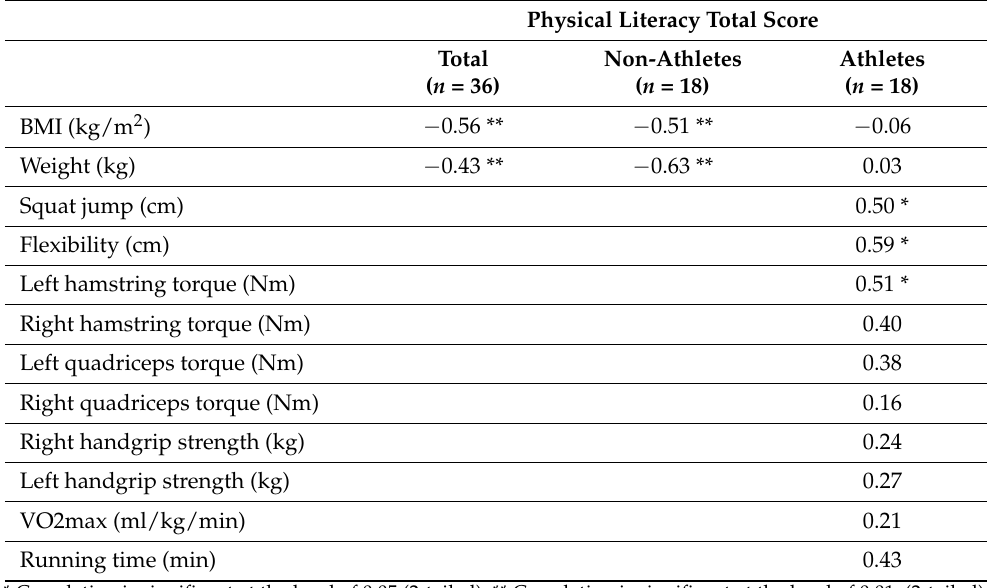
Table 3. Associations between perceived PL and weight, BMI, and physical fitness parameters.